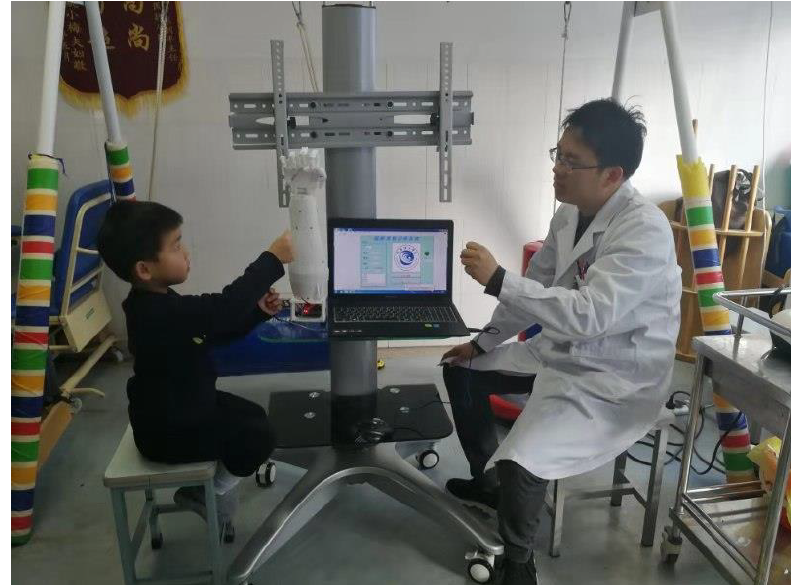
Figure 9. Bionic arm with RehabHand software usage in